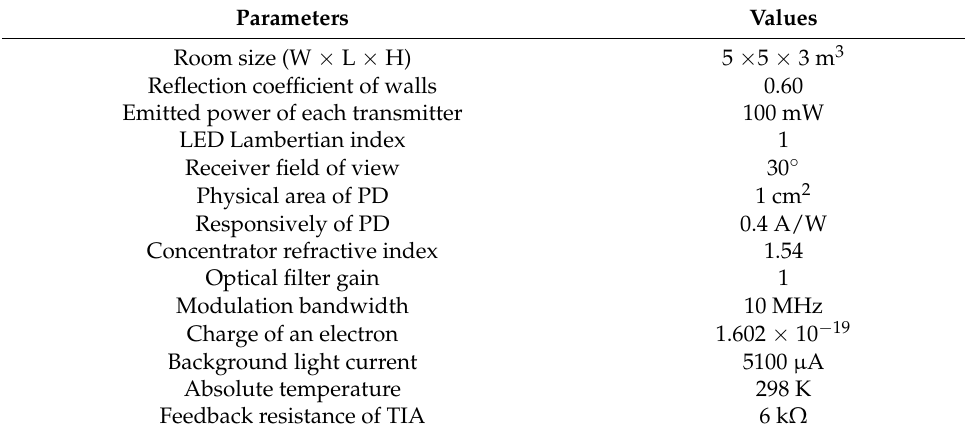
Table 1. Summarizes the main parameters for this work. Parameters